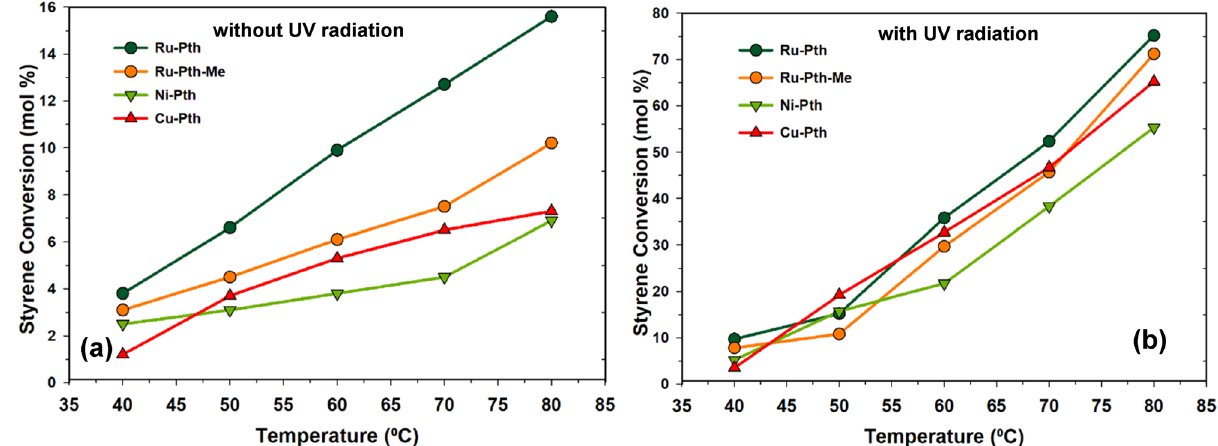
Figure 5. Effect of the temperature on the styrene conversion over Ru-Pth, Ru-Pth-Me, Ni-Pth and Cu-Pth complexes ( a ) without and ( b ) with UV radiation. Reaction conditions: catalyst: styrene (1:100); styrene to H 2 O 2 ratio of 1; acetonitrile: 50 mL; catalyst: 10 mg; reaction time: 3